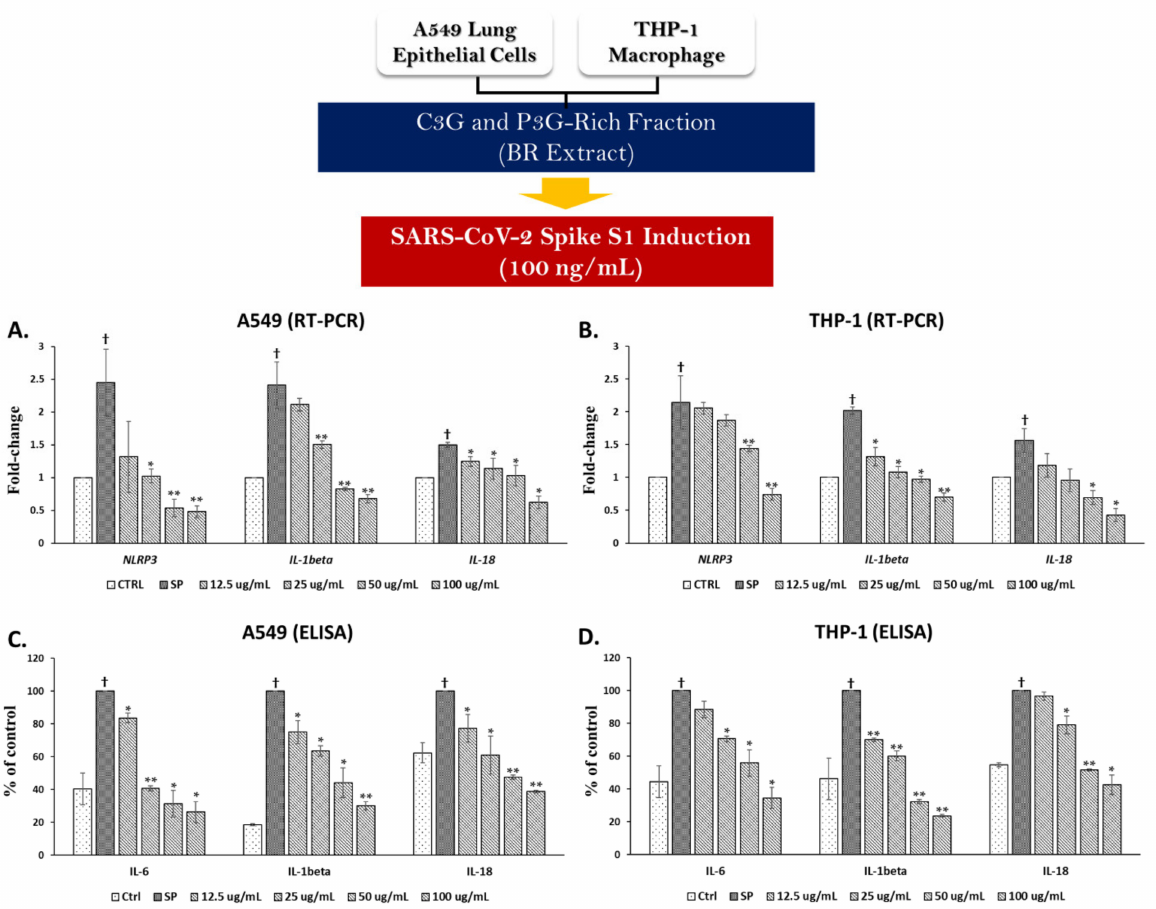
Figure 4. Anti-inflammation properties of BR extract upon SP induction in A549 lung cells and THP-1 macrophages. A549 (at 3 × 10 5 cell/well) and PMA-treated THP-1 macrophage (6.5 × 10 5 cell/well) were pre-treated with BR extract at the concentration of 0–100 µ g/mL for 4 h, and then challenged with 100 ng/mL of SP for 3 h, then the supernatant was collected, and total RNA was extracted using TRIzol ® reagent. The fold-change inhibition of inflammatory gene expressions ( NLRP3 , IL-1 β , and IL-18 ) in A549 cells ( A ) and in THP-1 macrophages ( B ) upon BR extract treatment were determined using RT-PCR. The effect of BR extract on the inhibition of cytokine production (IL-6, IL1 β , and IL-18) in A549 cells ( C ) and THP-1 macrophage ( D ) were determined using ELISA. Data are presented as mean ± S.D. values of at least three independent experiments. * p < 0.05, ** p < 0.01 vs. SP-induced control group. † p < 0.05 vs. non-treated control group. RT-PCR, Reverse transcription-polymerase chain reaction; ELISA, enzyme-linked immunosorbent